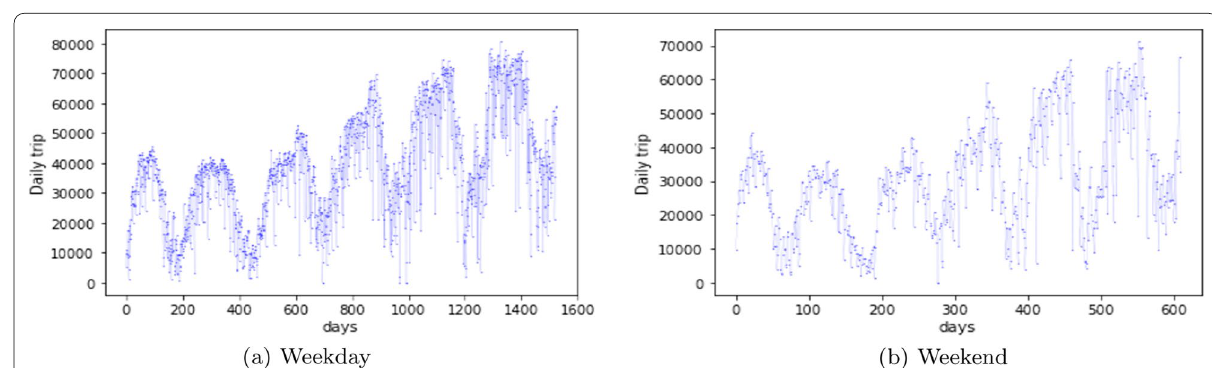
Fig. 2 The temporal patterns of the variations of bike-share